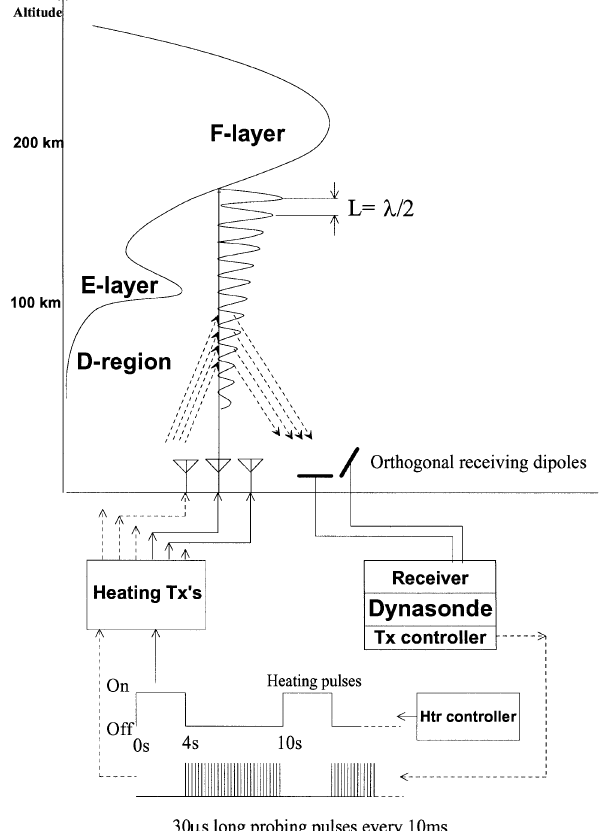
Fig. 1. Schematic diagram illustrating the single-frequency API ex- perimental arrangement at Troms (cid:249) . In this arrangement Bragg scattering is in principle possible throughout the whole height region up to the F layer if the irregularities are formed and have a